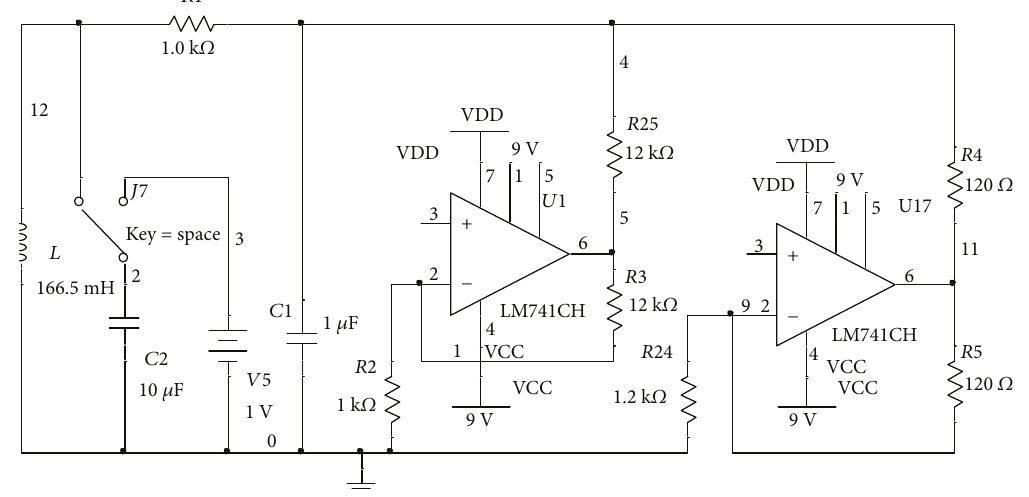
Figure 1: Chua ’ s circuit diagram.